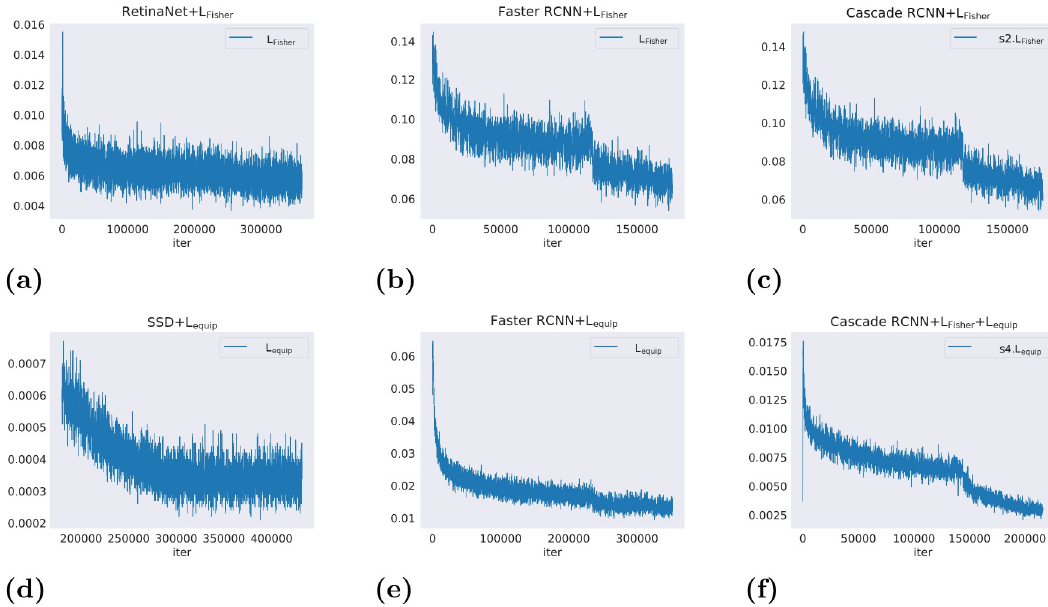
stage # in the case of multi-stage networks.